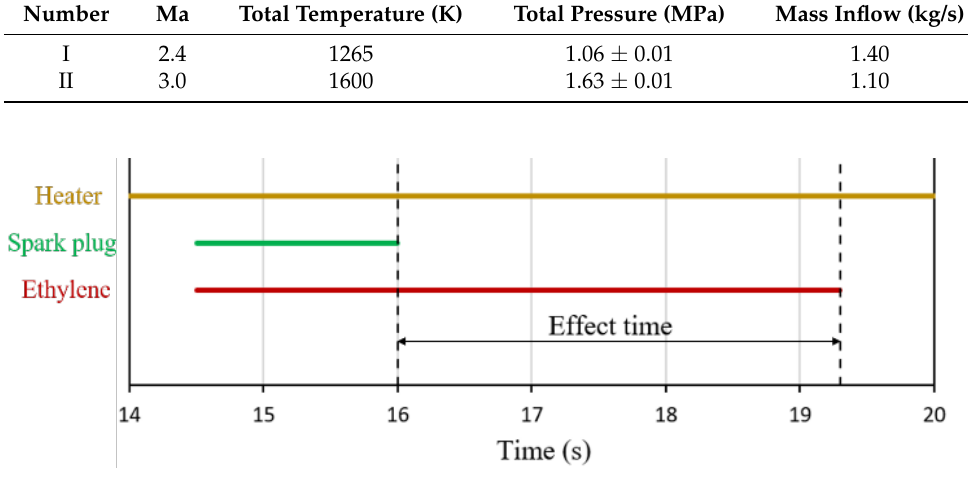
Figure 2. Sequence of valves and ignitors in test.